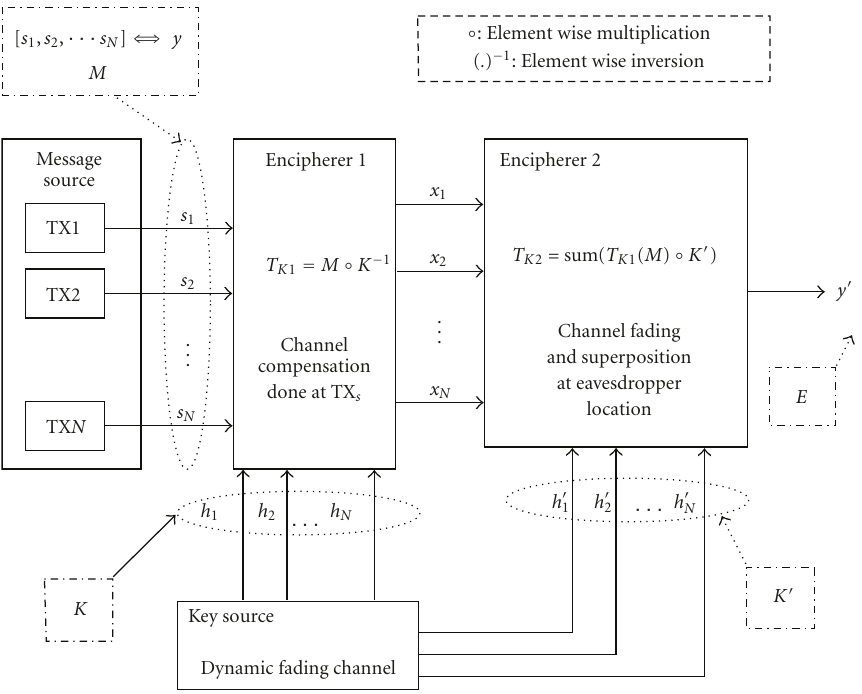
Figure 2: JCMA as a Shannon secrecy